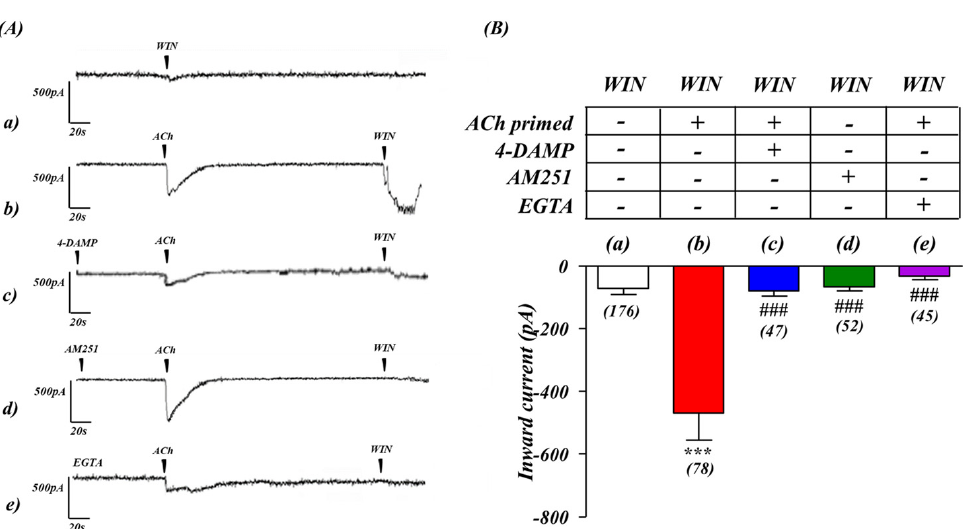
Figure 1. ACh ‘priming’ enhances inward current responses to CB 1 receptor activation in SH − SY5Y human neuroblastoma cells. ( A ) Whole cell voltage-clamp recordings from SH − SY5Y cells in culture. A small inward current after CB 1 receptor activation (WIN 55,212 − 2, 100 nM), was observed in SH − SY5Y cells ( a ), 5 min pre-application of acetylcholine (ACh, 1 µ M) greatly enhances the inward current induced by WIN 55,212 − 2 stimulation ( b ). Superfusion with either M 3 (4 − DAMP, 10 nM) or CB 1 (AM251, 1 µ M) receptor antagonists ( c , d respectively) were able to completely abolish the ACh priming effect on CB 1 receptors. During superfusion with Ca 2+ -free/EGTA (100 µ M) buffer, the ACh − dependent priming effect on CB 1 receptors was again abolished ( e ). ( B ) Histogram representation of the M 3 receptor priming on the subsequent cellular response induced by CB 1 receptor stimulation in presence of 4 − DAMP ( c ), AM251 ( d ) and EGTA ( e ). *** p < 0.001 vs. ( a ) WIN only, and ### p < 0.001 vs. ( b ) ACh-WIN. One-way analysis of variance followed by Multiple Comparison Test, with Bonferroni’s correction. n values for each experiment are shown in brackets below each